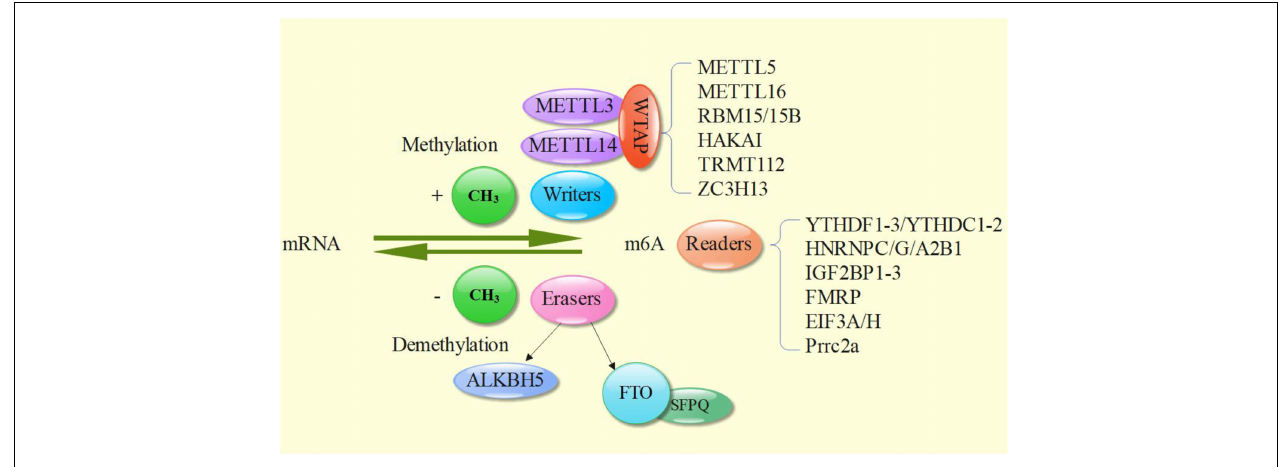
FIGURE 1 | Reversible process of m6A modification and three factors - Writer, Eraser, and